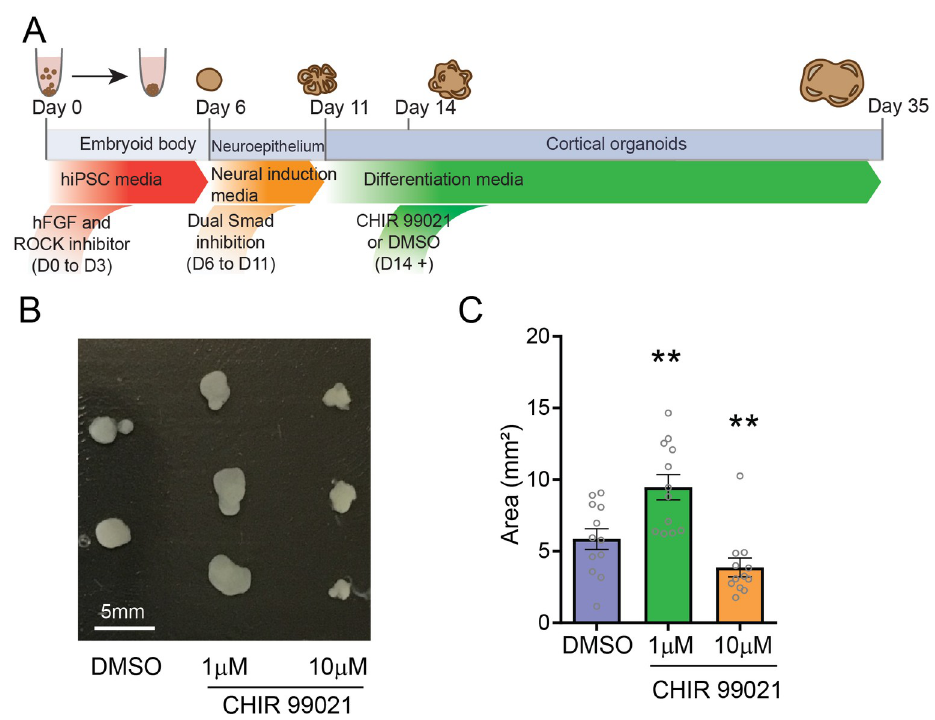
Fig 1. GSK3 β inhibition by CHIR 99021 during neuronal differentiation affects neurodevelopmental signaling pathways and organoid growth. A . Schematic of organoid production protocol. Dual SMAD inhibition was performed during the neural induction step. GSK3 β inhibitor CHIR 99021 (1 μ M, 10 μ M or 50 μ M), or vehicle DMSO, was added to the culture media throughout neuronal differentiation (day 14 and onward). B . Representative organoids at day 35 of organoid development; organoids treated with 50 μ M CHIR 99021 failed to grow. C . Quantification of organoid size. CHIR 99021 treatment had a dose-dependent effect on organoid size (DMSO: 5.856 ± 0.7229, n = 12; 1 μ M: 9.472 ± 0.8797, n = 12; 10 μ M: 3.294 ± 0.3062, n = 11; DMSO vs 1 μ M, �� : p-value = 0.0044; DMSO vs 10 μ M, �� : p- value = 0.0047; 1 μ M vs 10 μ M, p-value < 0.0001; unpaired t-tests). Bar graphs represent mean ±